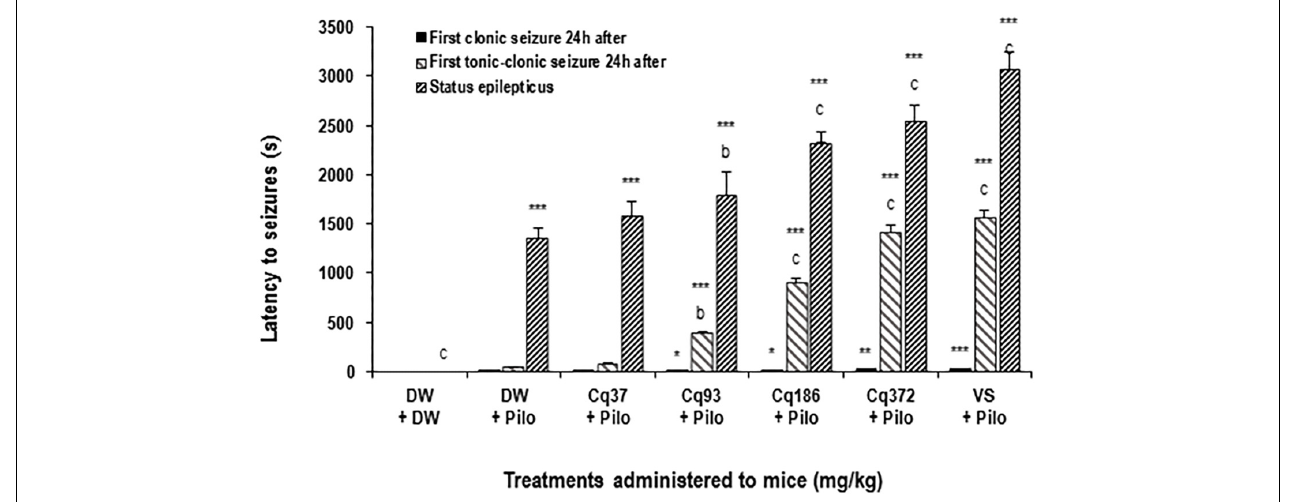
FIGURE 1 | Effects of C. quadrangularis extract on the latency to status epilepticus, to first clonic and tonic–clonic seizures 24 h after status epilepticus. Results are expressed as mean ± SEM for six animals. Data were analyzed by one-way ANOVA, followed by Tukey (HSD). ∗∗∗ p < 0.001, vs control animals (DW + DW group) receiving only distilled water; b p < 0.01 and c p < 0.001 vs disease control animals (DW + Pilo group) receiving distilled water and pilocarpine (360 mg/kg). DW, distilled water; Cq, Cissus quadrangularis ; Pilo, pilocarpine; SV, sodium valproate (300 mg/kg). ∗ p < 0.05, ∗∗ p < 0.01.